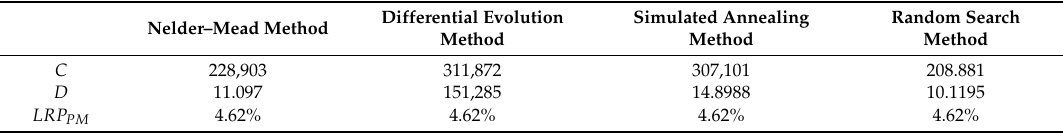
Comparative financial losses using different computational methods for imperfect preventive